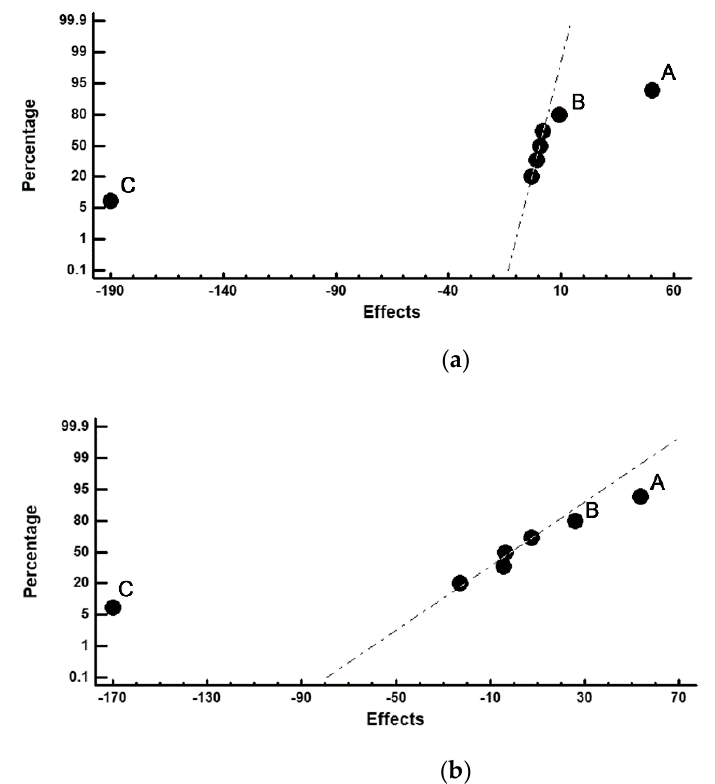
Figure 7. Representation of the effects on a normal probability plot. Those factors are highlighted which have a significant effect on hardness at an approximate distance of 2 mm from the termination of the nitrided layer. ( a ) Vickers hardness with a load of 300 N; ( b ) Vickers hardness with a load of 0.5 N applied to the constituent matrix.